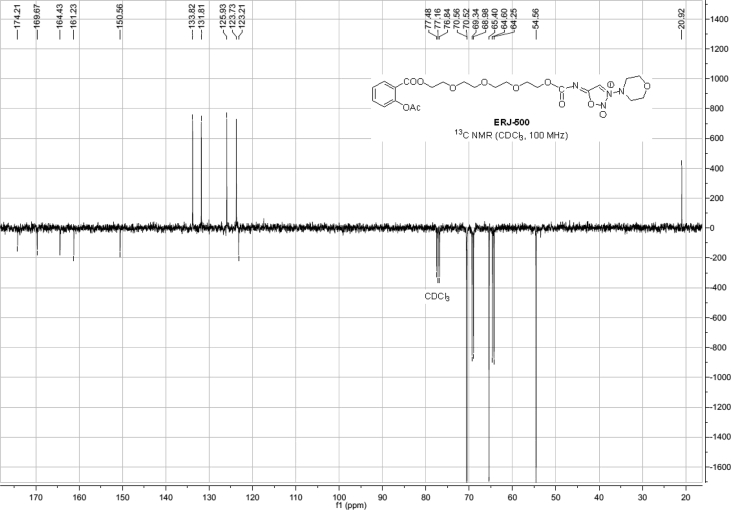
13C NMR spectra of compound ERJ-500.